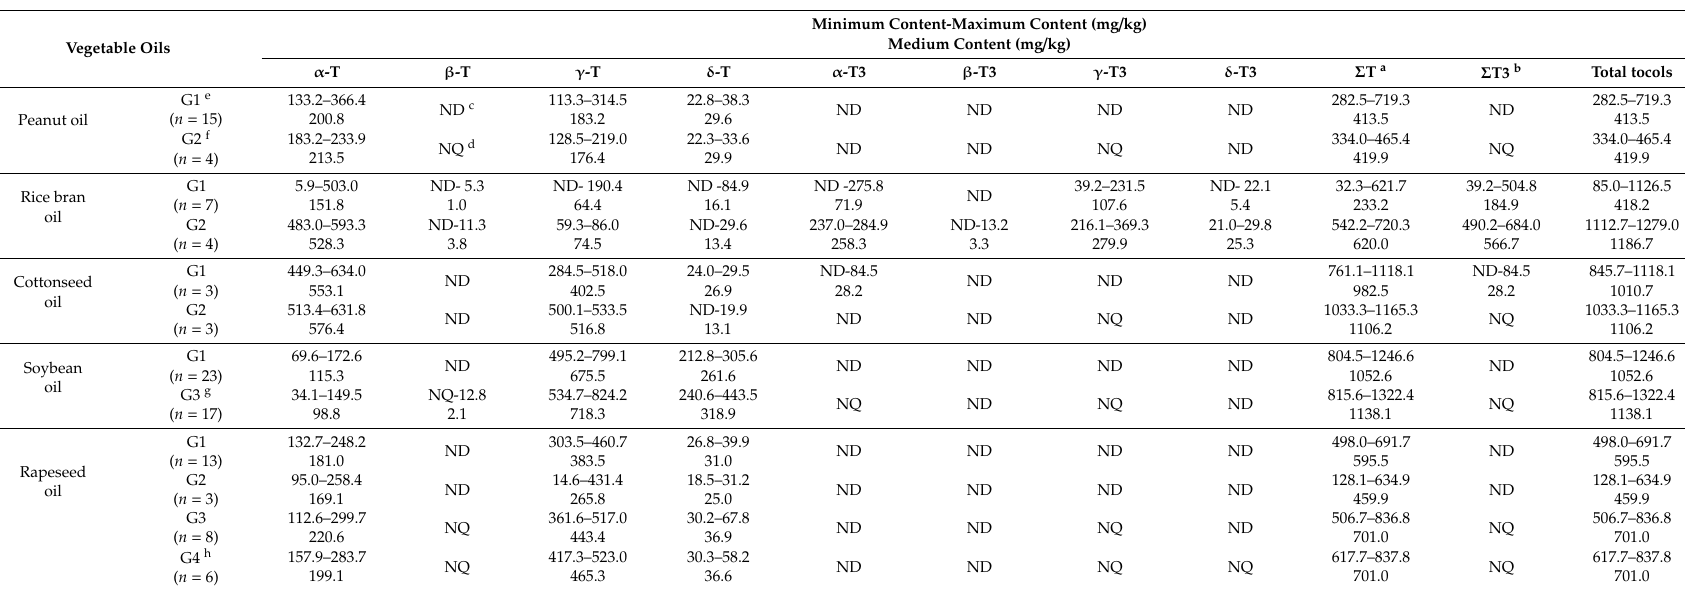
Table 4. The compositions and contents (mg / kg) of tocols in five types of selected traditional edible oils containing di ff erent